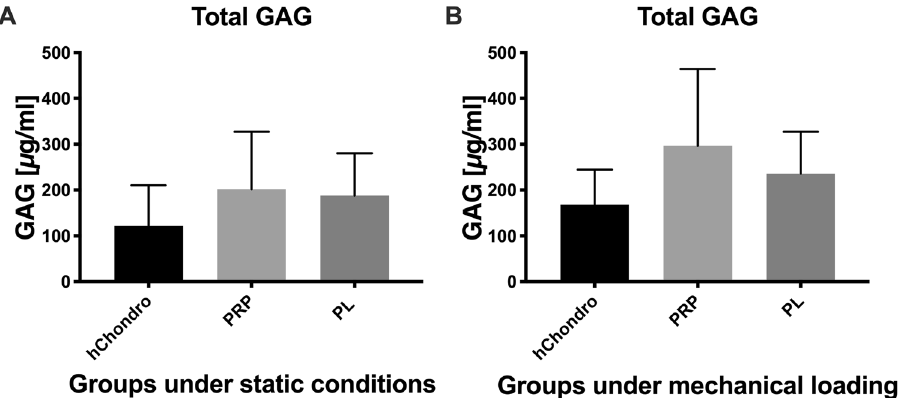
Figure 2. GAG quantification of human chondrocytes (hChondro), PRP and PL groups shown under static conditions ( A ) and mechanical stimulation ( B ), shown as mean + SD, statistical significance was defined as p <